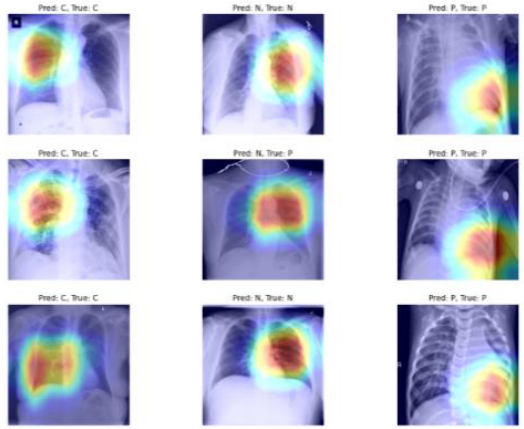
Figure 10. Raw chest X-ray image corresponding to Figure 9 and Grad-CAM visualization generated using the following model: Xception model + coordinated attention module + LSTM layer + new classification head.